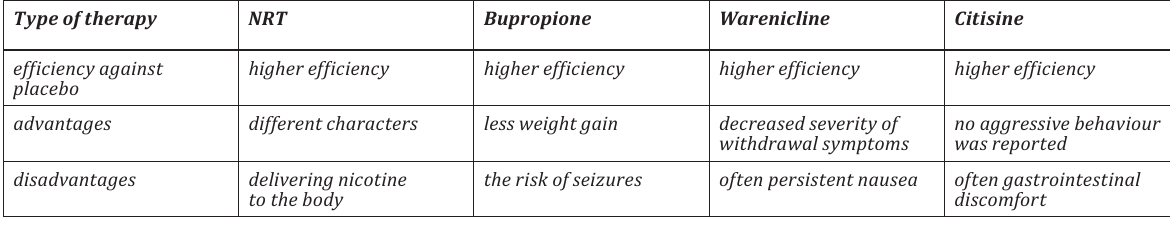
Table 1. Comparison of some nicotine addiction therapy methods